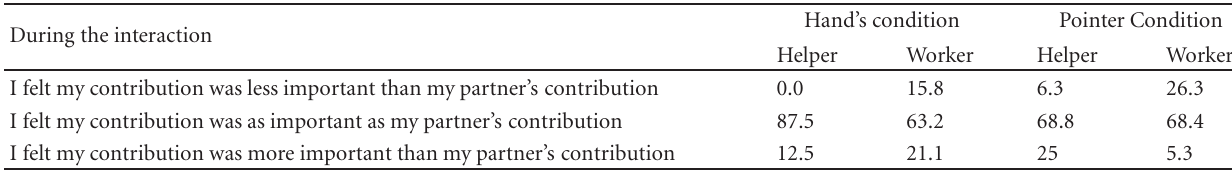
Table 3: Perceived contribution to task solving in percentage.